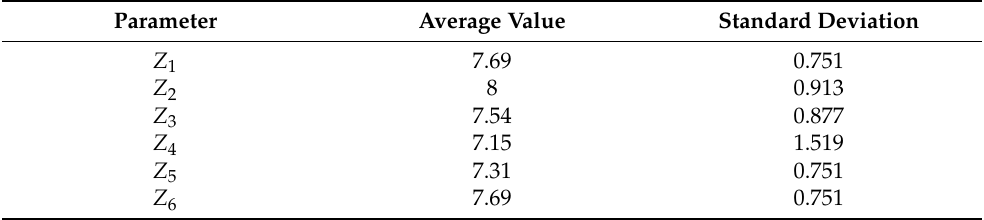
Table 9. Average values and standard deviations of sample parameters.